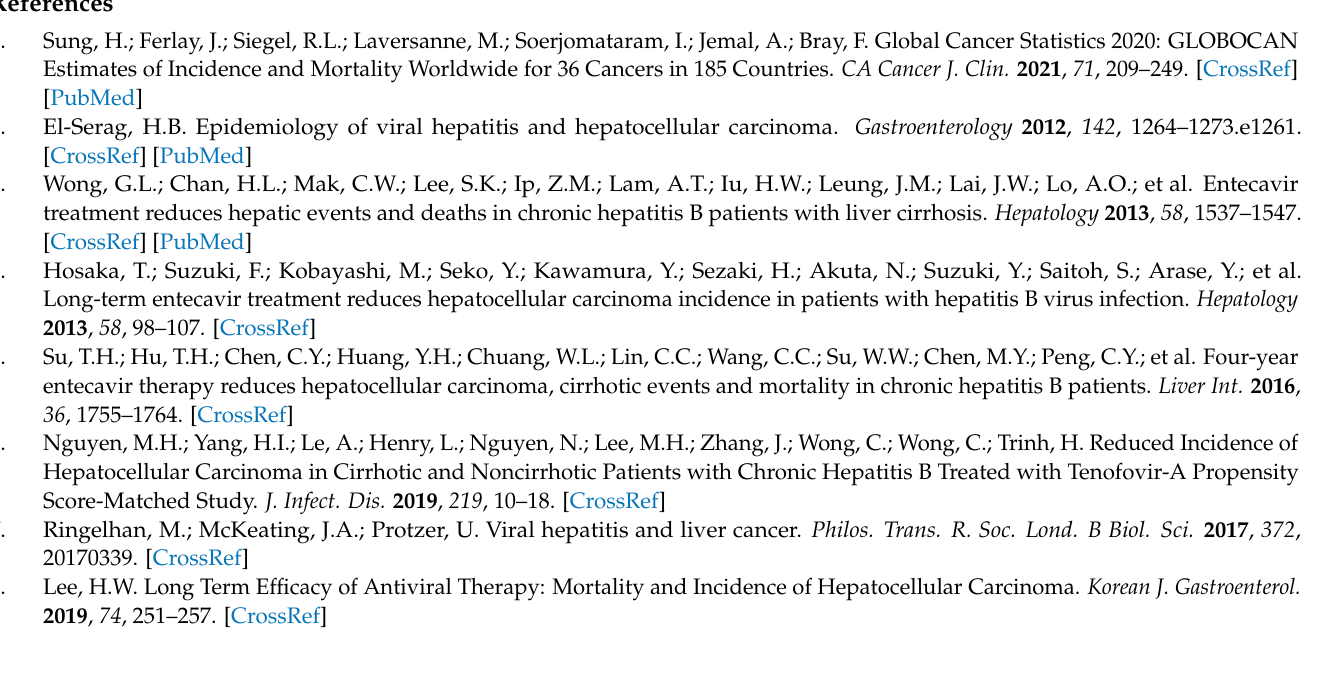
culation; Figure S1: Study process flowchart; Figure S2: Kaplan–Meier graphs of hepatocellular carcinoma according to the statistically significant and independent variables; Table S1: Baseline characteristics of the included and excluded patients; Table S2: Incidence Rate and Univariate Anal- ysis of the Potential Predictors of Hepatocellular Carcinoma in the Derivation Cohort ( n = 1239); Table S3: Projected Hepatocellular Carcinoma Risk for the ACCESS score; Table S4: Model-based Risk of Hepatocellular Carcinoma by Actual Cumulative